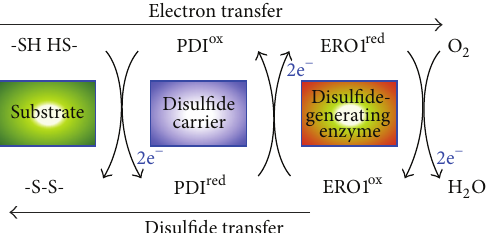
Figure 1: Disulfide relay from ERO1 to PDI in the ER. Disulfide bond formation involves electron transfer from the substrate to a disulfide carrier protein (e.g., PDI) and then to a de novo disulfide- generating enzyme (e.g., ERO1). PDI directly transfers a disulfide to two Cys residues of a substrate protein by means of a thiol-disulfide exchange reaction. The reduced form of PDI is reoxidized by ERO1, which relays the oxidizing power from molecular oxygen, via the FAD cofactor, to the reduced form of PDI.